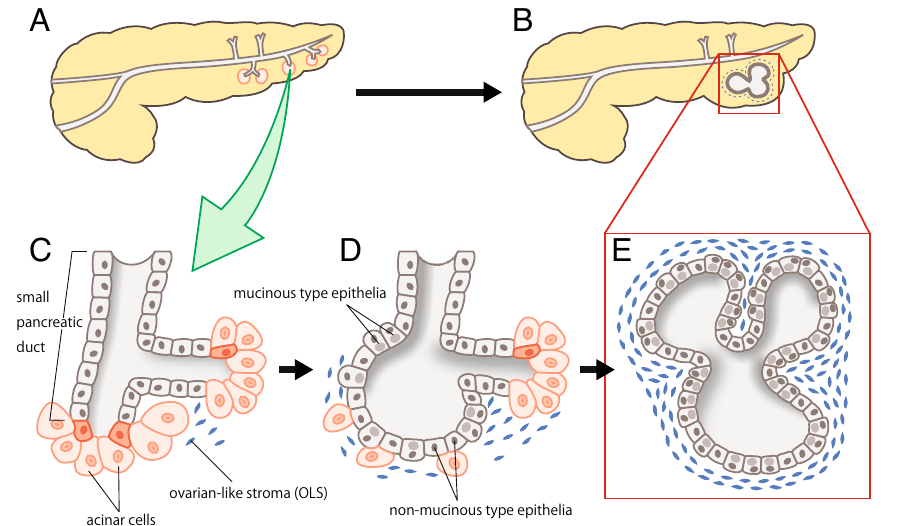
Figure 4. Schematic hypothesis on the development of mucinous cystic neoplasm (MCN). ( A , B ) Whole view of the pancreas containing early-phase MCN ( A ) and late-phase MCN ( B ). ( C – E ) Closer view of very early- phase MCN ( C ), early-phase MCN ( D ), and late-phase MCN ( E